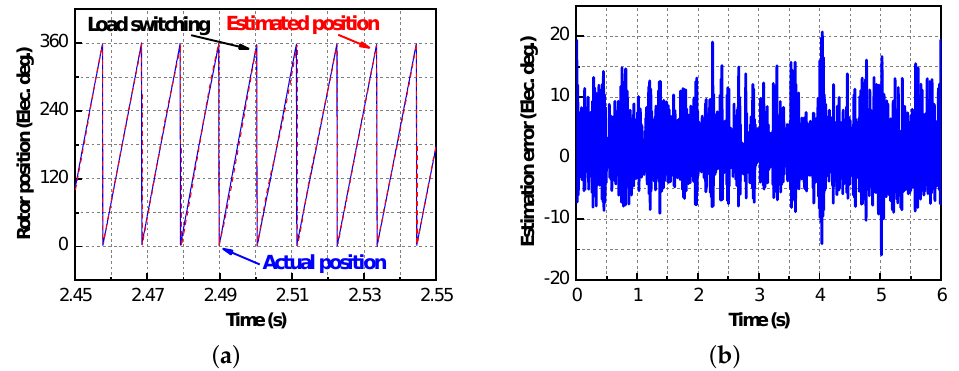
Figure 19. Simulation results of rotor position using the constant inductance. ( a ) Rotor position and ( b ) estimation